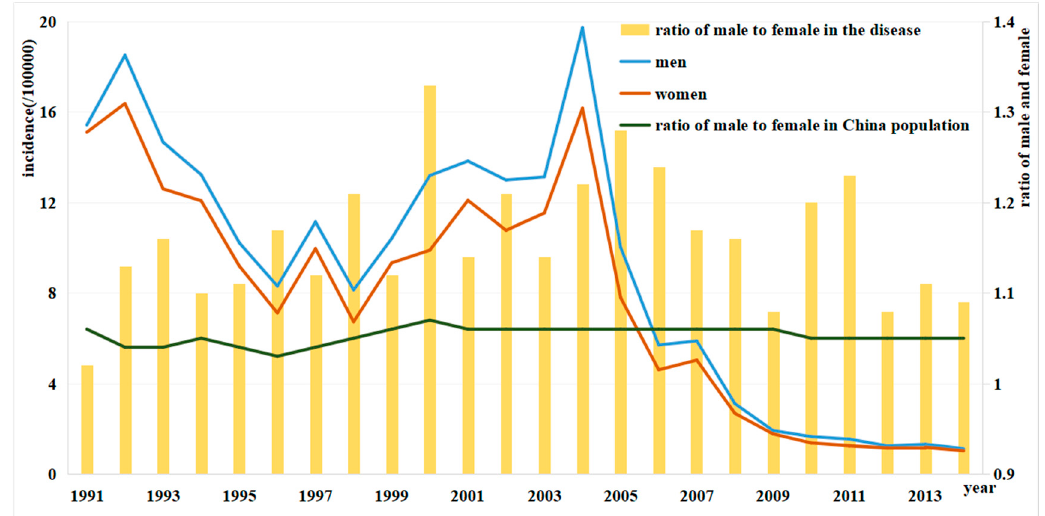
Figure 7. Gender distributions of typhoid and paratyphoid patients in Zhejiang from 1991 to 2014.